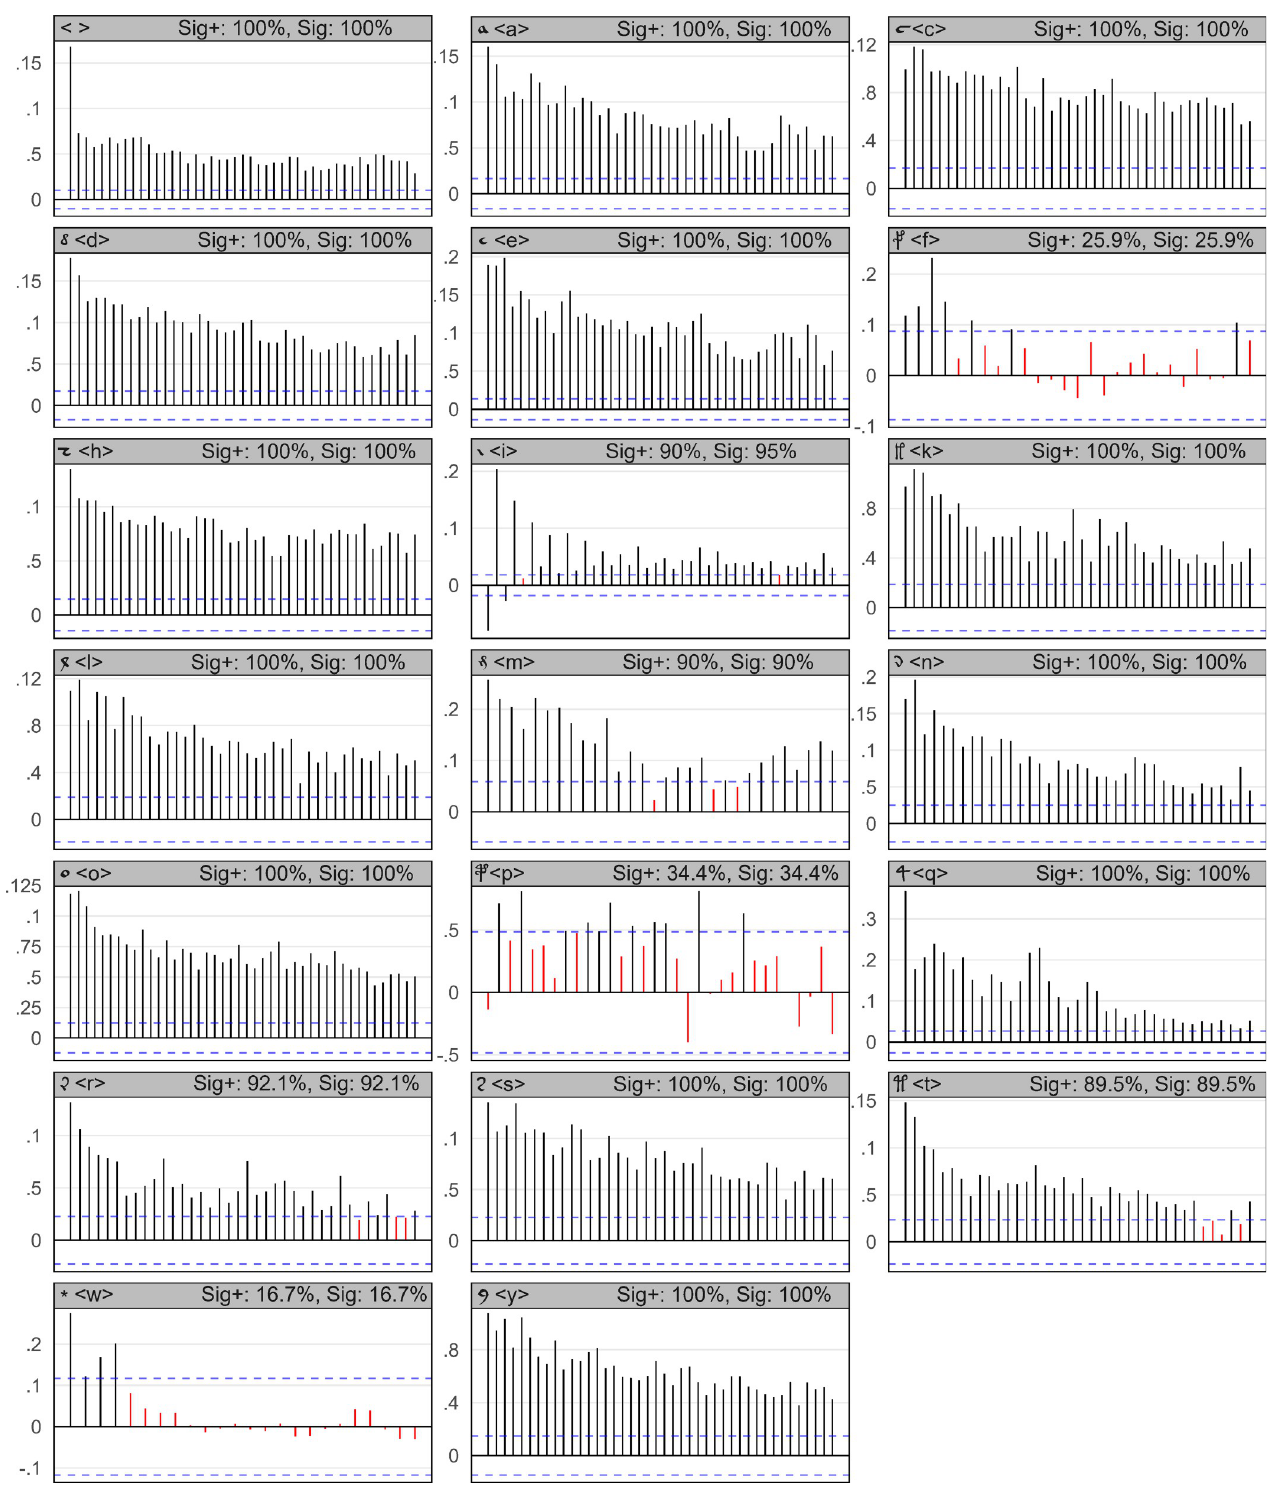
Fig 4. Autocorrelation plots for the Voynich manuscript and its individual symbols. Symbols with a frequency > 100, analogical to the previous Fig 3. The x axis shows lags, starting at 1, from left-to-right; y axis shows the Pearson correlation; blue horizontal lines are the statistical significance levels. ‘Sig+’ stands for the percentage of ‘significant and positive’ lags, ‘Sig’ stands for ‘significant’ lags. Unexpected behavior of symbol repetition may be observed.